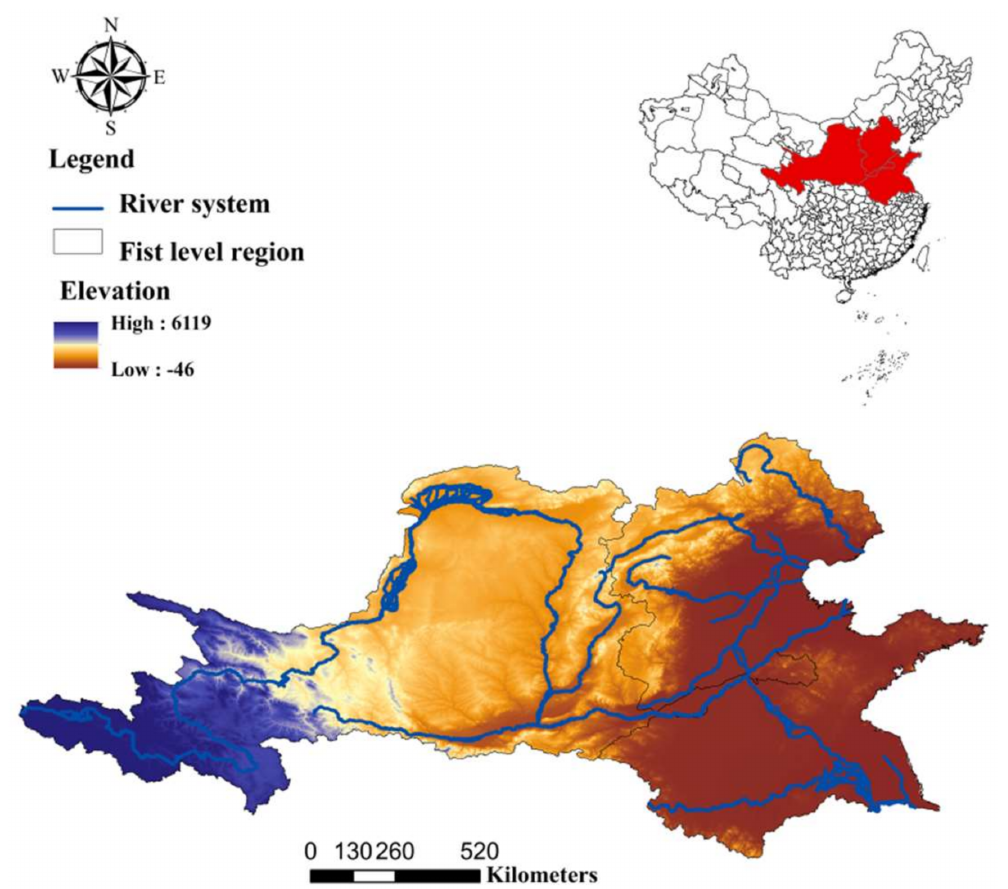
Figure 1. The map of the study area. The river system of the Huang-Hui-Hai River Basin, including the Yellow River, Hai River, and Huai River. The elevation of the basin is relatively high in the west and low in the east. The location of this basin is also marked in the map of China for